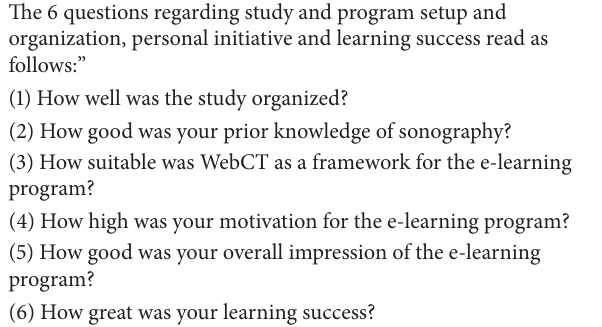
revealed a minimum number of students completing all study parts of fifteen.